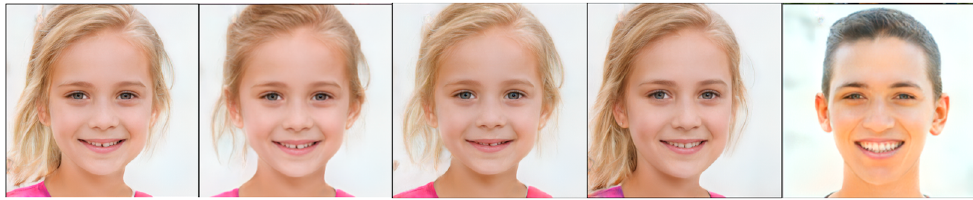
Figure 1. Generated human face image editing on semantic attributes of hairstyle, age, pose, and gender respectively.